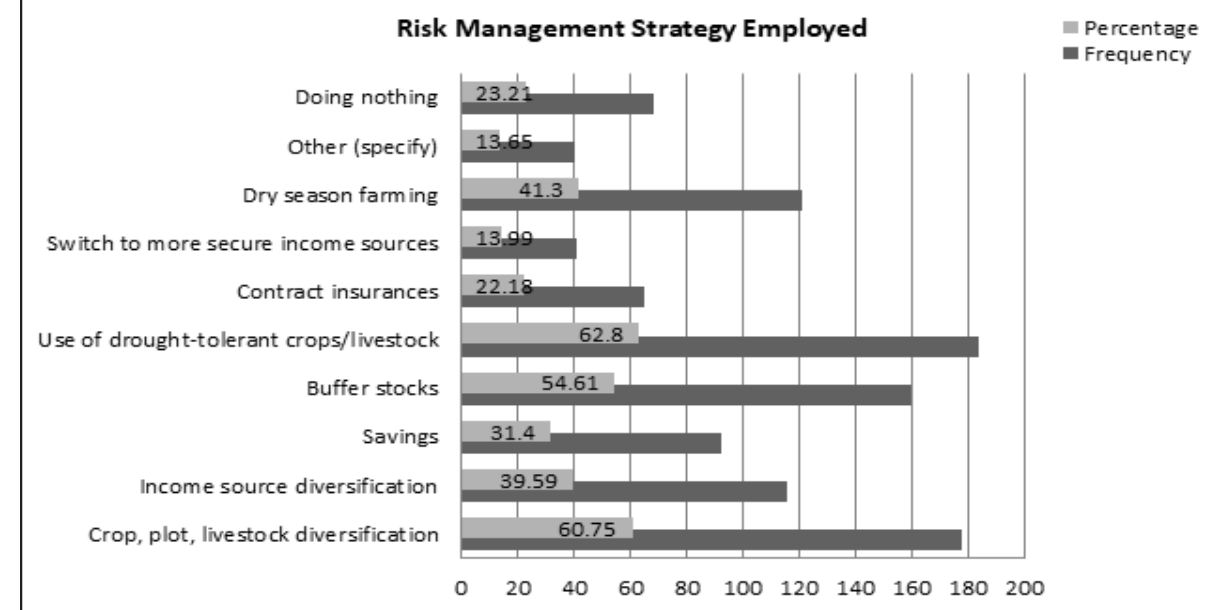
Figure 2: Risk Management Strategy Employed by Farming